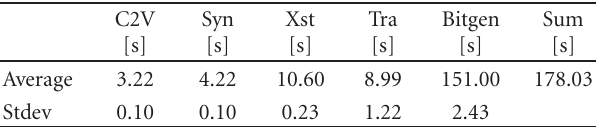
Table 7: Constant overheads involved in the ASIP-SP. C2V corre- sponds to the Netlist Generation phase in Figure 2. Syn, Xst, Tra, and Bitgen are the FPGA CAD tool flow processes and correspond to the syntax check, synthesis, translate, and partial reconfiguration bitstream generation processes, respectively, which can be found in the third phase in Figure